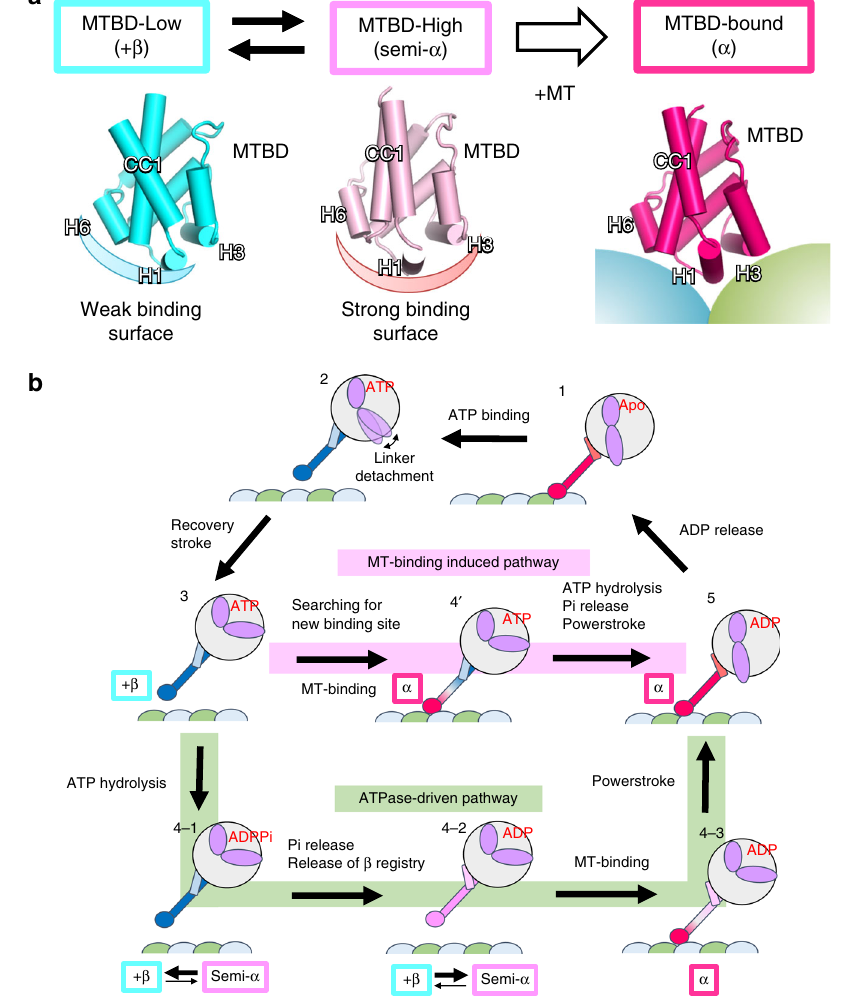
Fig. 6 The proposed mechanism for two-way communications between MTBD and ATPase domain during the mechanochemical cycle of dynein. a The three conformational states of MTBD revealed in this study. In the MT-unbound state, MTBD undergoes conformational equilibrium between MTBD-Low (left, + β -registry) and MTBD-High (middle, semi- α -registry). MT binding induces conformational changes of MTBD with sliding of CC1 ( α -registry). b Mechanochemical cycles of dynein. In the ATPase-driven pathway (green), the hydrolysis of ATP (3 to 4 – 1) and subsequent release of Pi (4 – 1 to 4 – 2) shift the equilibrium of MTBD toward semi- α state (4 – 2) to increase the MT-binding af fi nity. After MT binding, the stabilized α -registry transmits the conformational changes to ATPase domain, thereby facilitating the powerstroke movements of the linker (4 – 3 to 5). In the MT-binding-induced pathway (pink), the ATP-bound dynein searches for a new binding site in the low-af fi nity state. Upon MT binding, the stabilization of the α -registry transmits the conformational changes to the ATPase domain, which facilitates ATP hydrolysis, Pi release, and the powerstroke all at